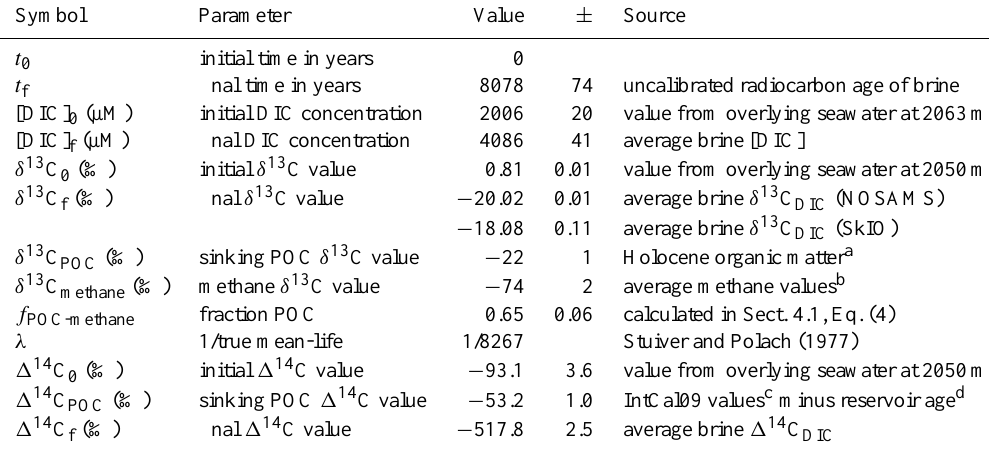
Table 2. Box model parameters, values and uncertainties.